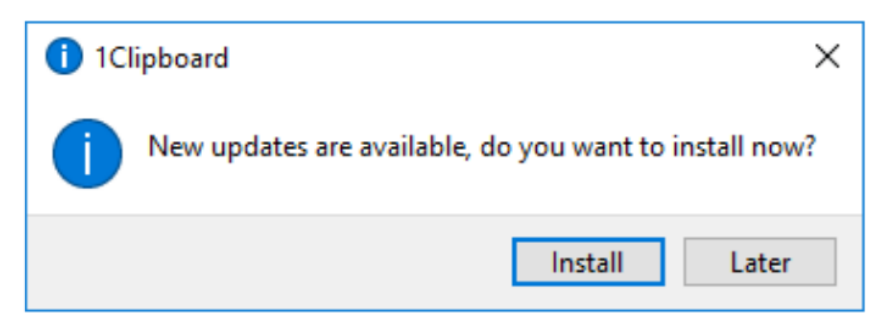
Figure 2. Man-In-The-Middle forcing an